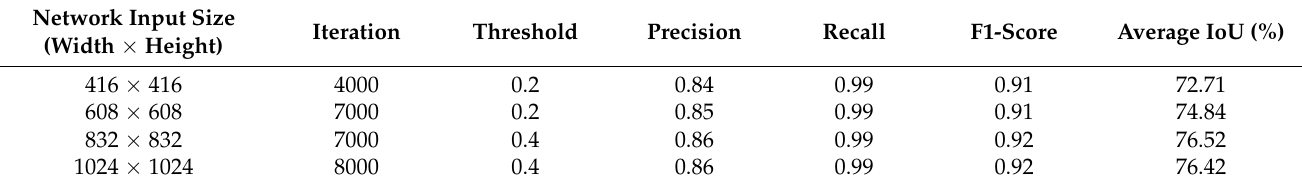
Table 6. The best model for each network input size on YOLOv3 is based on training and valida- tion.